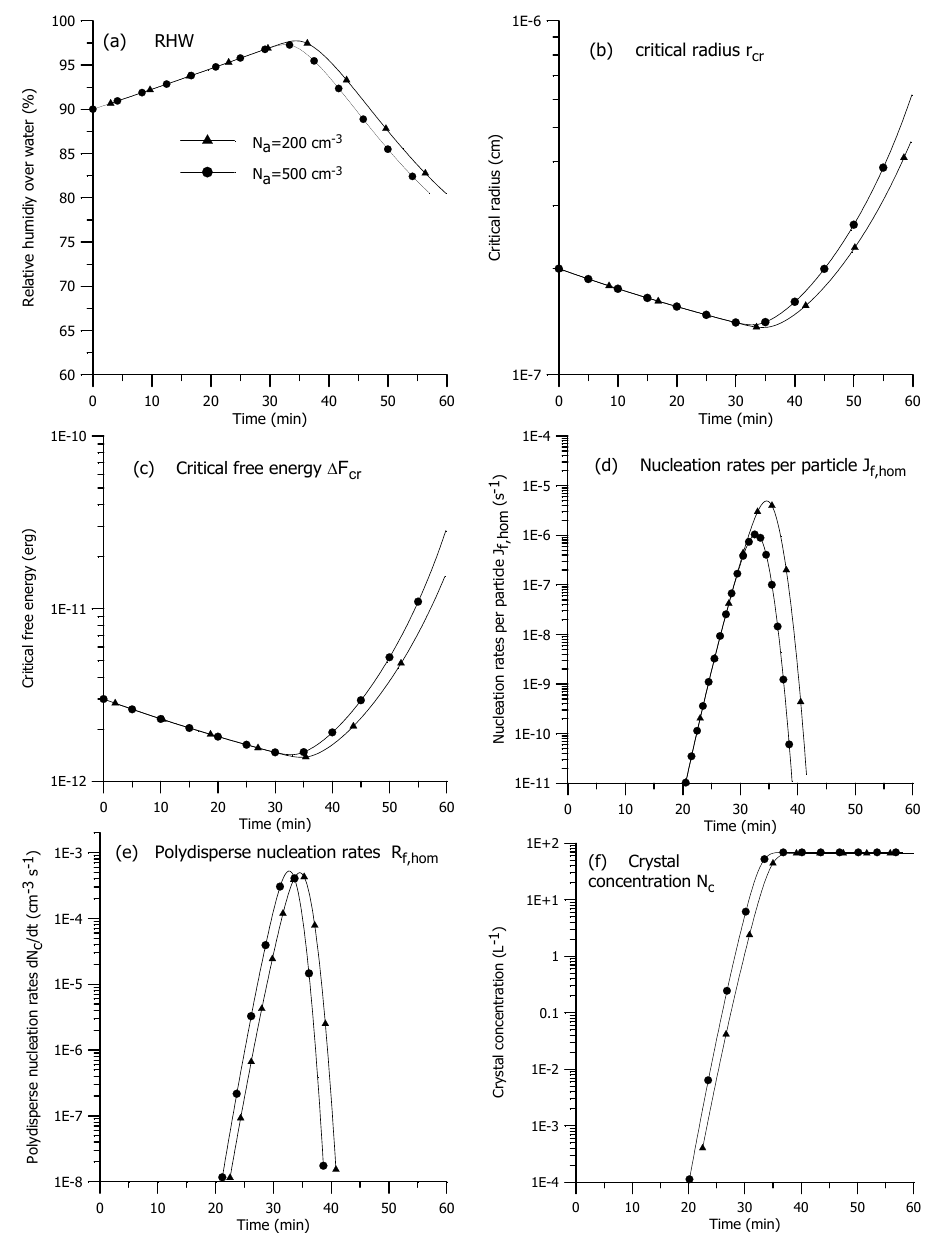
Fig. 3. Comparison of homogeneous nucleation kinetics at N a = 200cm − 3 and 500cm − 3 . The other parameters are: T 0c = − 40 ◦ C, RHW 0 = 90%, p 0 = 340hPa, w = 4cms − 1 . (a) Relative humidity over water RHW, defined as 100 · S w , th ; (b) critical radius r cr ; (c) critical free energy 1F cr ; (d) homogeneous J f , hom r 3 a nucleation rates for a particle with radius of 0.11 µm; (e) polydisperse nucleation rates, R f , hom = d N fr / d t , defined by Eq. (18d); (f) crystal